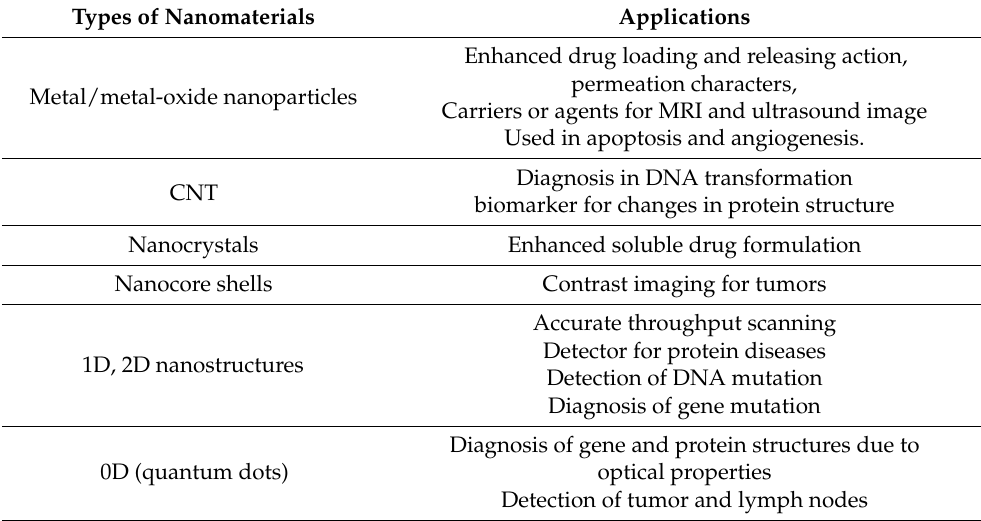
Table 1. Application of different nanomaterials in the field of medical